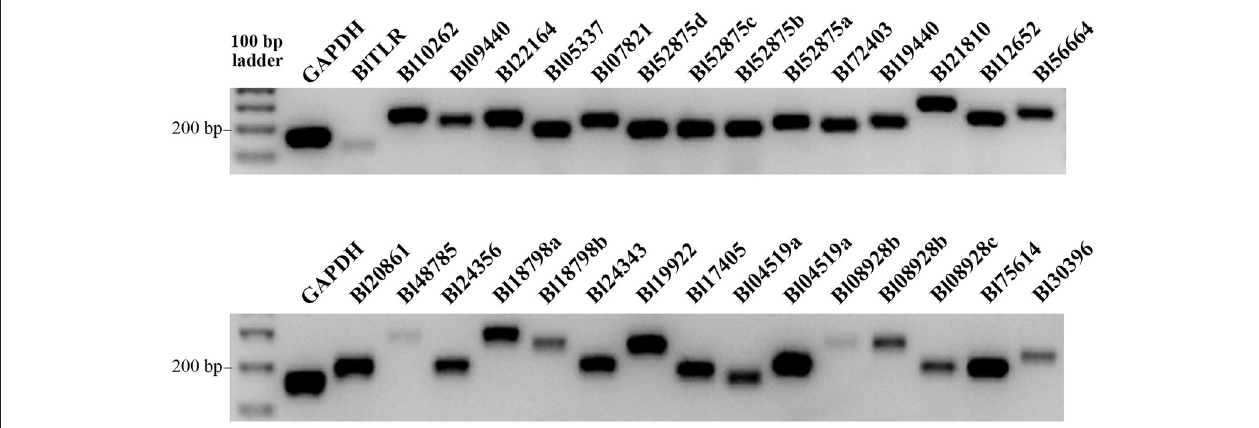
FIGURE 2 | Expression of TLR genes in B. lanceolatum . The cDNA used in all amplifications was prepared from whole animals. RT-PCR reactions were accomplished using equal number of cycles, the PCR products were loaded equally on two 1% agarose gels and GAPDH was used as a reference gene. Images were taken with the same exposure time using a Geldoc.